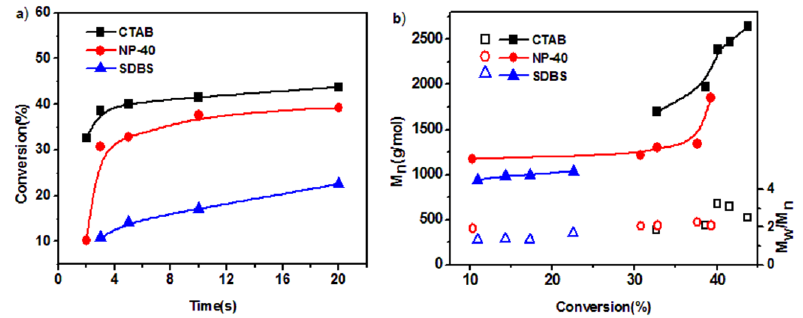
Figure 6. IBVE cationic polymerization initiated by CumOH/B(C 6 F 5 ) 3 /Et 2 O in emulsion at 20 ◦ C: ( a ) conversion vs. time; ( b ) M n and M w / M n vs. conversion; [IBVE] = 1.6 M; [CumOH] =